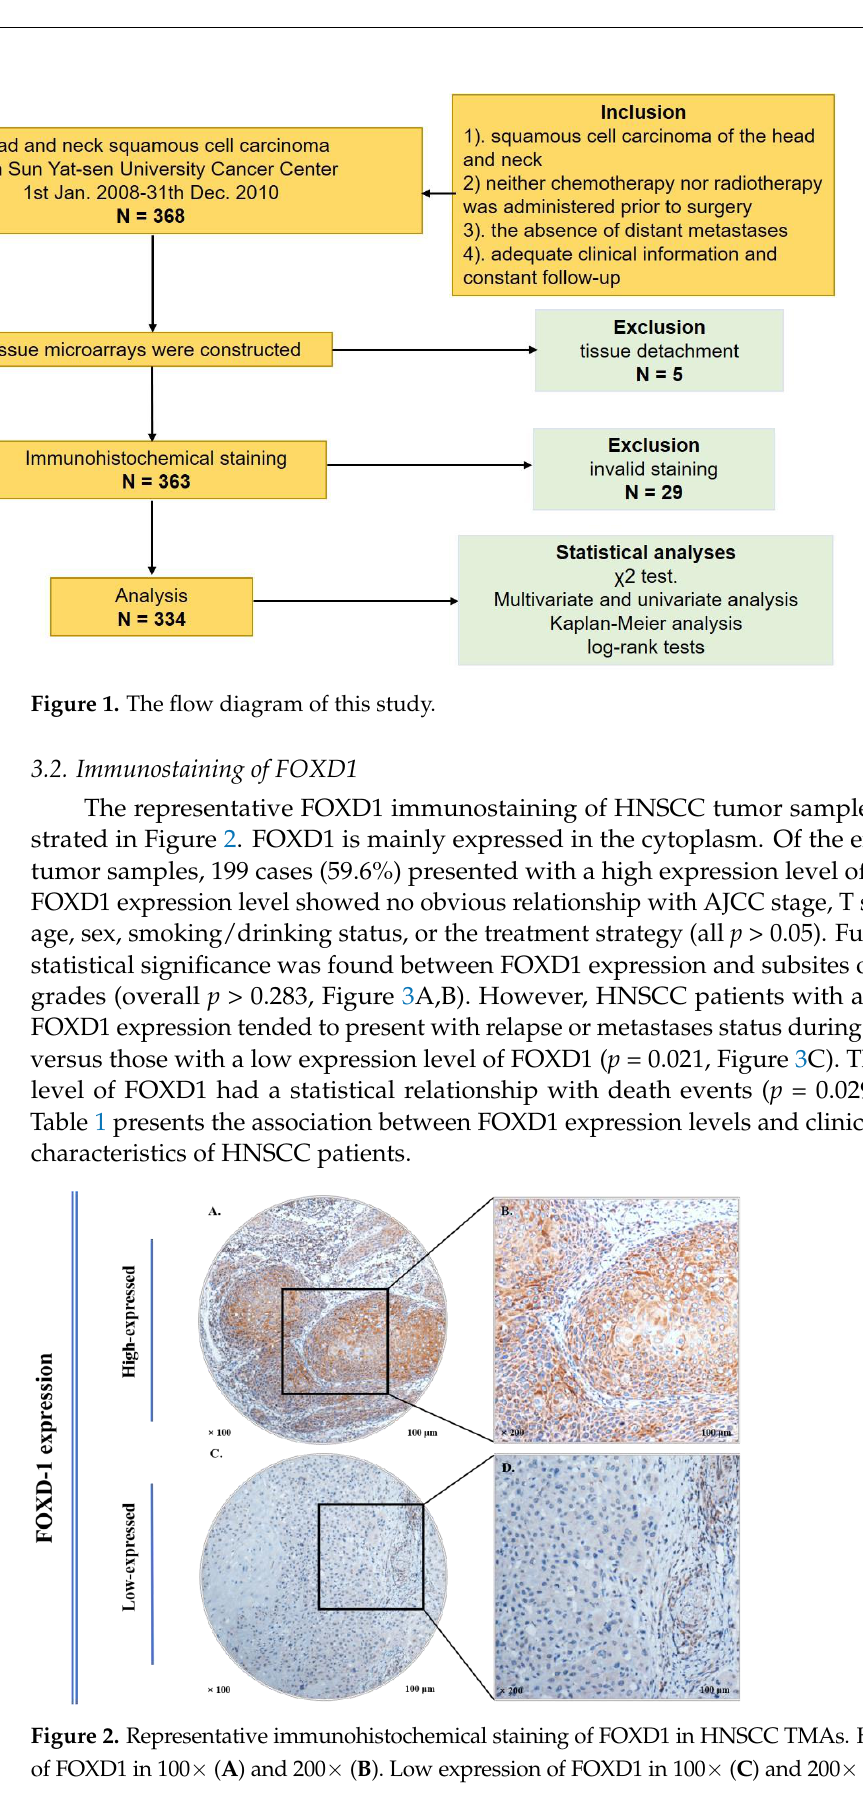
Figure 3. Association between subsites ( A ), histological grade ( B ), recurrence/metastasis ( C ) or death event ( D ) and FOXD1 expression. 3.3. Correlation between Survival and FOXD1 Expression Univariate analysis revealed that gender, histological grade, subsites, T stage, N stage AJCC stage, treatment modality, and FOXD1 expression level were associated with the overall survival of HNSCC patients (all p < 0.05, Table 2). However, T stage and subsites had no statistical relationship with DFS (all p > 0.05).